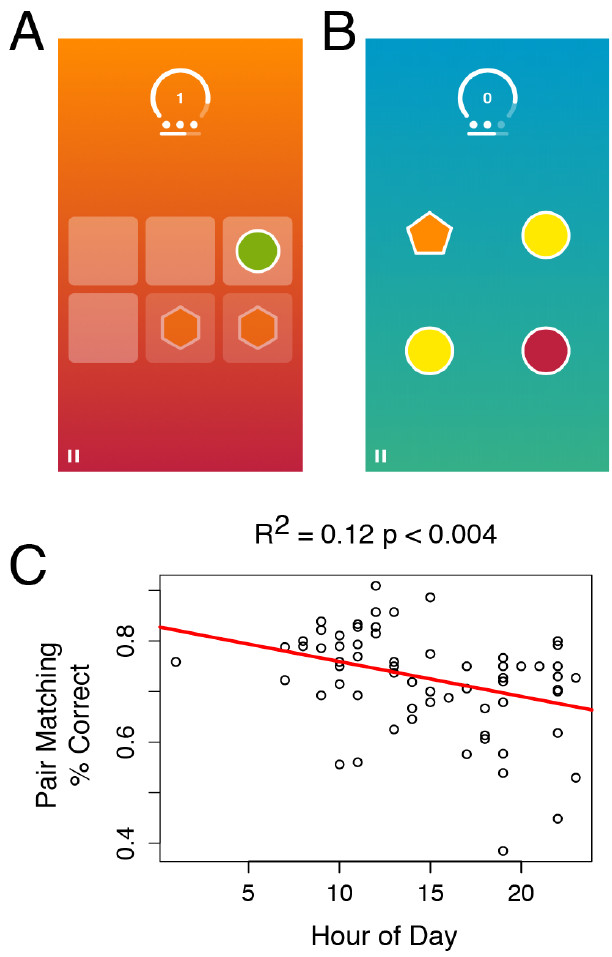
Figure 3. Performance in a working memory game, but not a focal attention game, declined with time of day. (A) The working-memory intensive Pair Matching game required the user to turn over cards and match all pairs within a 3-sec time window or a life was lost. The game ended when the user lost three lives. (B) The focal attention-intensive Object Mismatch game required the user to select the mismatched object within a 3-sec window. As with Pair Matching, the game ended when the user lost three lives. (C) Performance on the Pair Matching game declined with time of